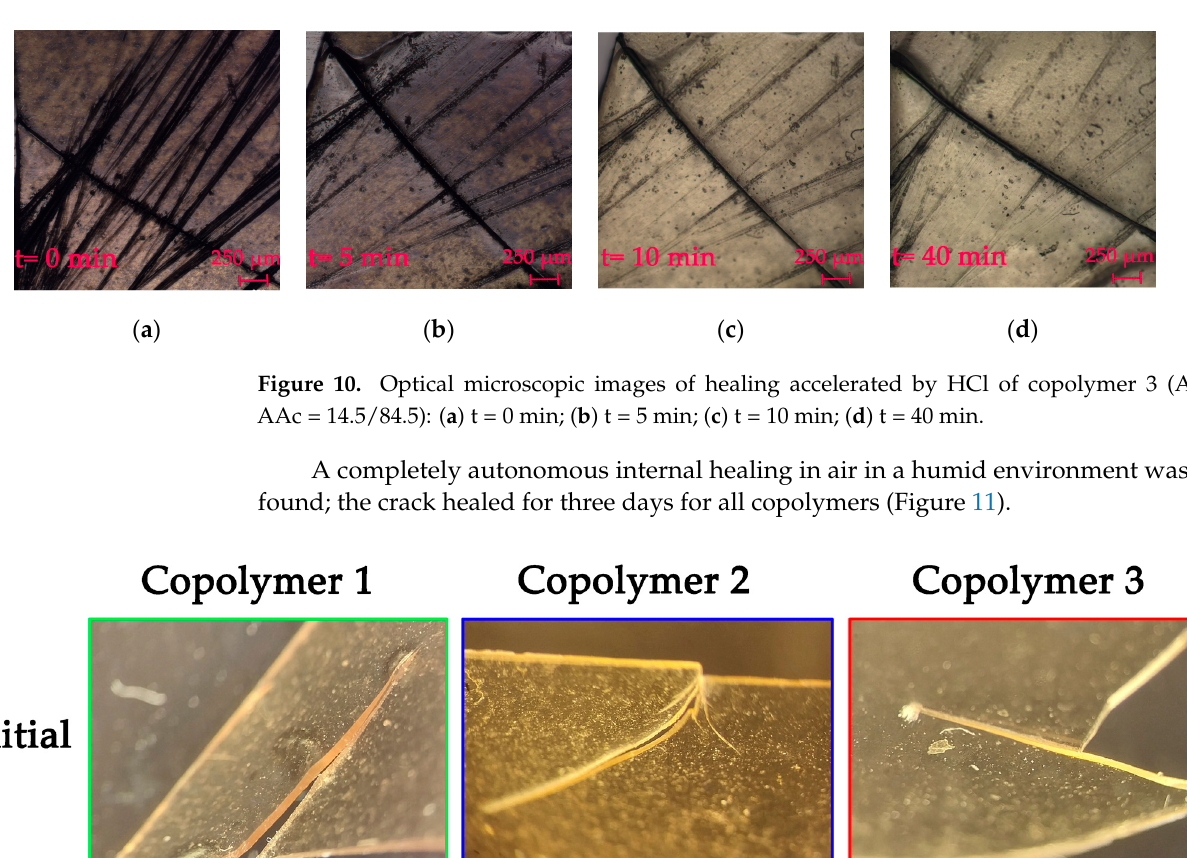
Figure 9. Optical microscopic images of healing accelerated by HCl of copolymer 2 (AAm/AAc = 49.5/49.5): ( a ) t = 0 min; ( b ) t = 1 min; ( c ) t = 5 min; ( d ) t = 10 min.